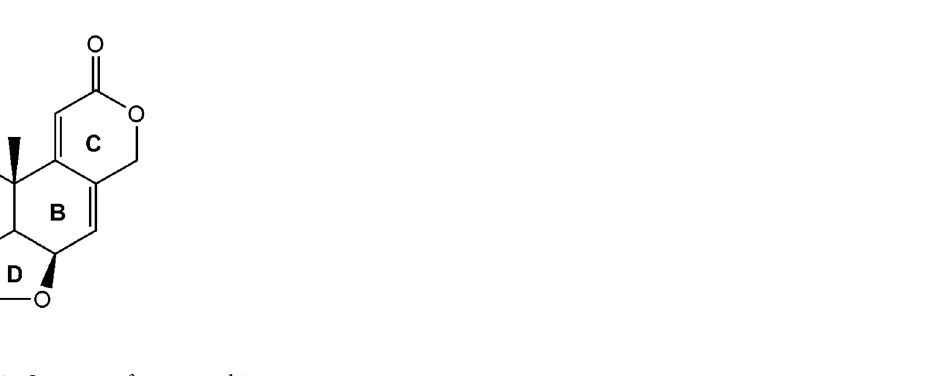
Figure 4. Structure of compound 1